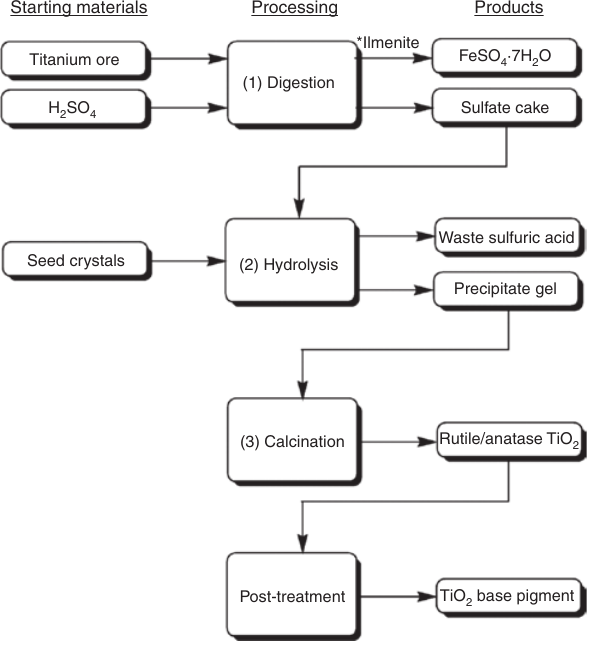
Figure 1: Representation the various stages of the sulfate process used for the manufacture of TiO . Reprinted with permission from 2 Ref. [15]. Copyright 2004 Royal Society of